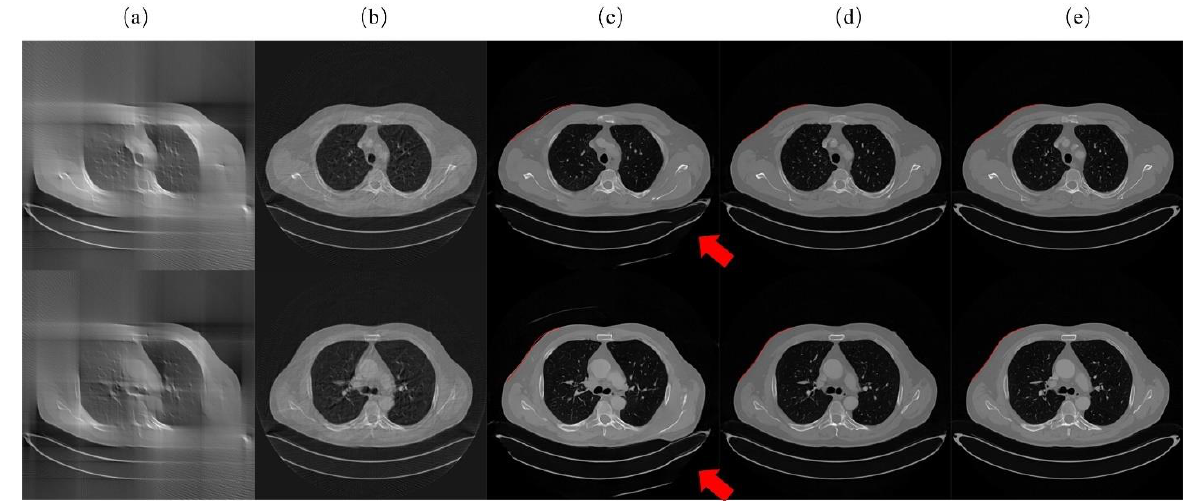
Figure 6. Artifact-removed results of AR-GAN. ( a ) FBP reconstruction for 90 ◦ limited-angle data; ( b ) FBP reconstruction for the output of SI-GAN; ( c ) Output of AR-GAN with ( a ) as input; ( d ) Output of AR-GAN with ( b ) as input; ( e ) Ground truth of reconstruction image. The red line is a hand-drawn outer profile of ( e ). (Best viewed with zoom-in).